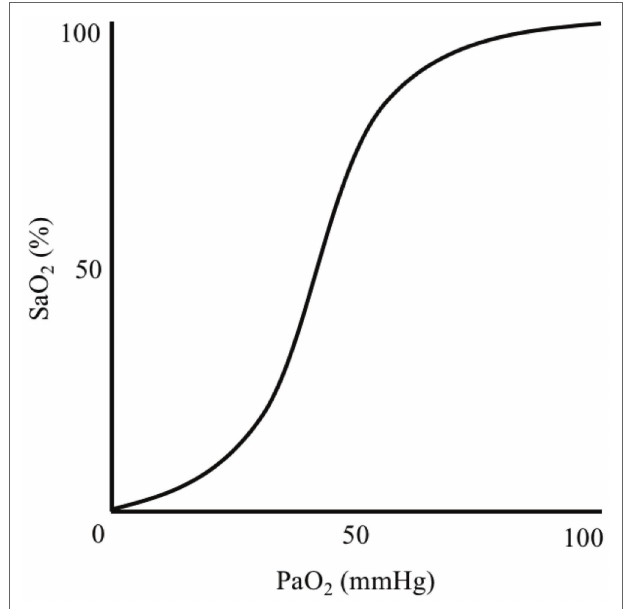
FIGURE 1 | Illustration demonstrating the sigmoidal relationship between arterial blood oxygen-haemoglobin saturation (SaO 2 ) and oxygen partial pressure (PaO 2